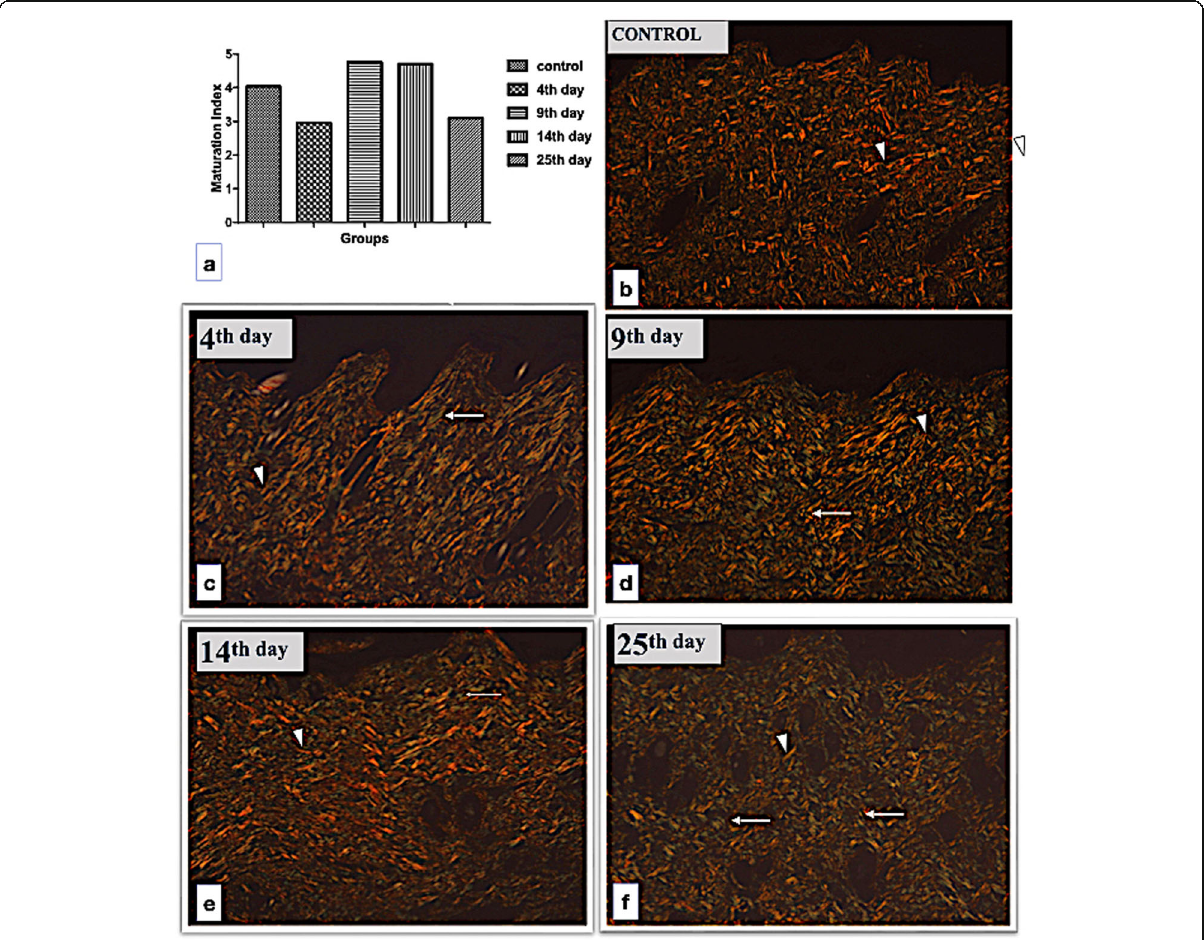
Fig. 3 Maturation index of collagen fibers ( a ) and representative images of the dermis layer of the skin obtained from Picrosirius red staining under polarized light for each time point evaluated after x-ray irradiation. Control ( b ), day 4 ( c ), day 9 ( d ), day 14 ( e ), and day 25 ( f ). Type I collagen fibers in red (arrowhead) and type III collagen fibers in green